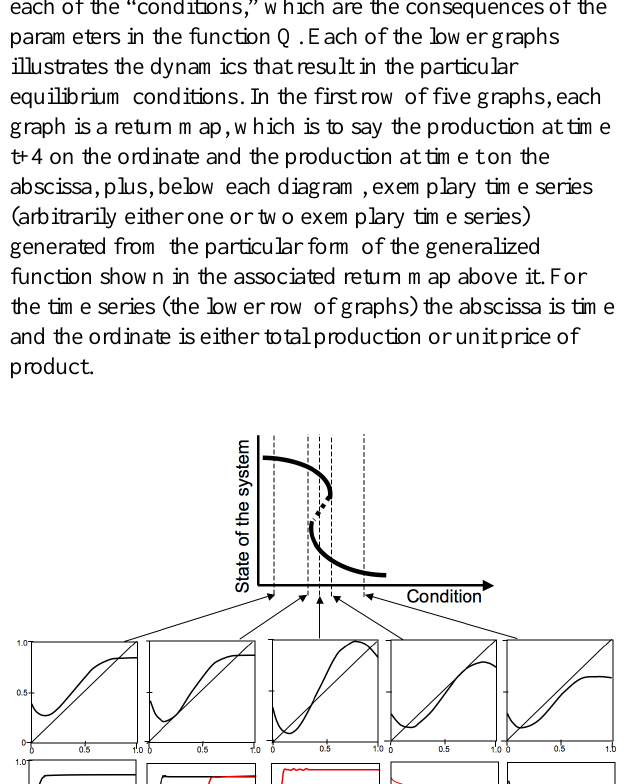
Fig. 3 . Change in the conditions as a function of the simple Fig. 4 . Potential changes in the underlying conditions dynamic model, A = h[m{g[f(At)]}]. We assume resulting from different manifestations of the dynamic t+4 nonlinear response for at least one of the functions in the model. The upper graph gives the equilibrium conditions for composed function. each of the “conditions,” which are the consequences of the parameters in the function Q. Each of the lower graphs a. Repeat of Figure 1b with the colored equilibrium points illustrates the dynamics that result in the particular corresponding to the colored functions in part b (where the equilibrium conditions. In the first row of five graphs, each function crosses the 45 degree line is an equilibrium point). graph is a return map, which is to say the production at